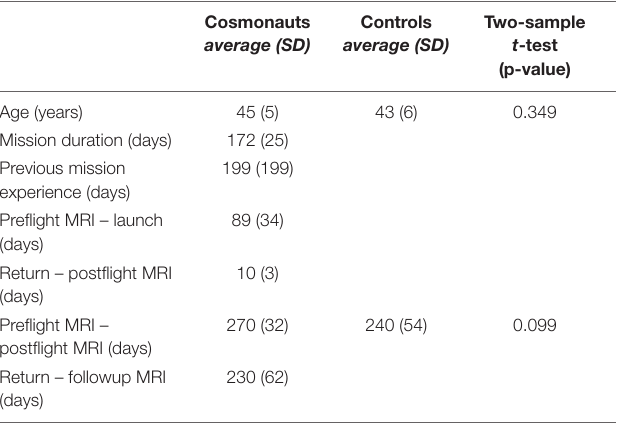
TABLE 1 | Demographic information of cosmonaut and control group